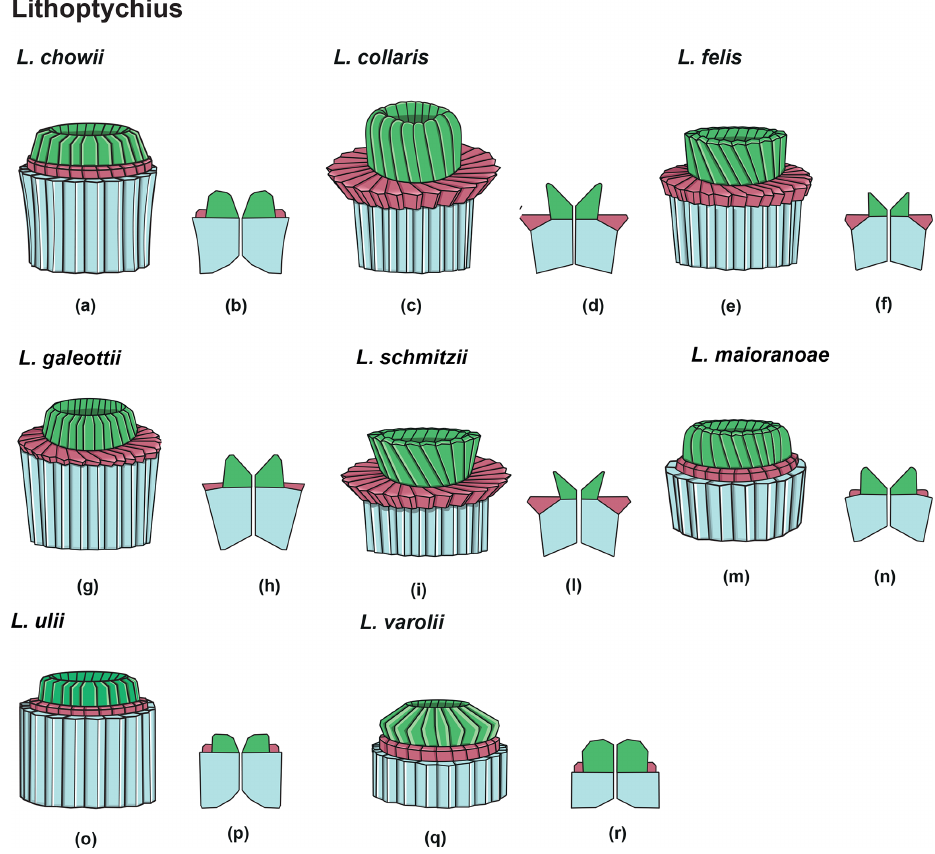
Figure 14. Overview of Lithoptychius : column (light blue), collaret (red) and calyptra (green). (a) Schematic drawing of the type species L. chowii . (b) Schematic cross section of L. chowii . (c) Schematic drawing of L. collaris . (d) Schematic cross section of L. collaris . (e) Schematic drawing of L. felis . (f) Schematic cross section of L. felis . (g) Schematic drawing of L. galeottii . h) Schematic cross section of L. galeottii . (i) Schematic drawing of L. schmitzii . (l) Schematic cross section of L. schmitzii . (m) Schematic drawing of L. maioranoae . (n) Schematic cross section of L. maioranoae . (o) Schematic drawing of L. ulii . (p) Schematic cross section of L. ulii . (q) Schematic drawing of L. varolii . (r) Schematic cross section of L. varolii